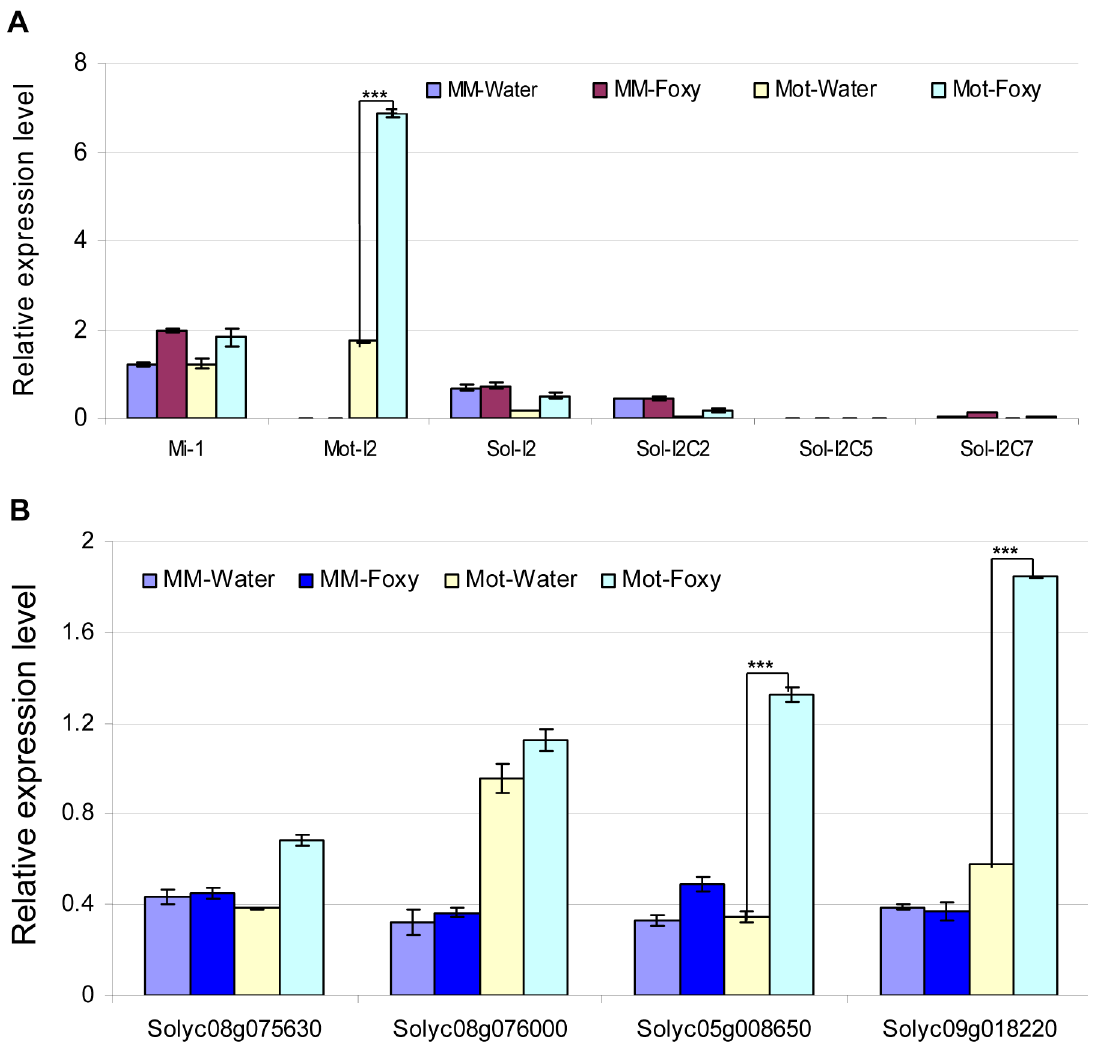
Figure 4. Determination of mRNA levels for control genes and predicted targets in tomato cultivars using qRT-PCR. Total tomato root RNA was used for qRT-PCR with gene-specific primers. Errors are expressed as the standard error. * and *** indicate significant differences when compared to the corresponding control plants in the same treatments at p , 0.05 and p , 0.001, respectively. A. Transcript levels of Mi-1 , I-2 and four I-2 homologs. Motelle and Moneymaker have different alleles of Mi-1 [89], while Moneymaker appears to lack I-2 . The prefix ‘‘Mot’’ signifies that the indicated I-2 homolog has been previously identified in Motelle [28], while ‘‘Sol’’ indicates that the homolog was found during BLAST searches of the Sol database. B. Expression of the four predicted target genes. Solyc08g075630 and Solyc08g076000 are predicted targets of slmiR482f, while Solyc05g008650 and Solyc08g018220 are predicted targets of slmiR5300.